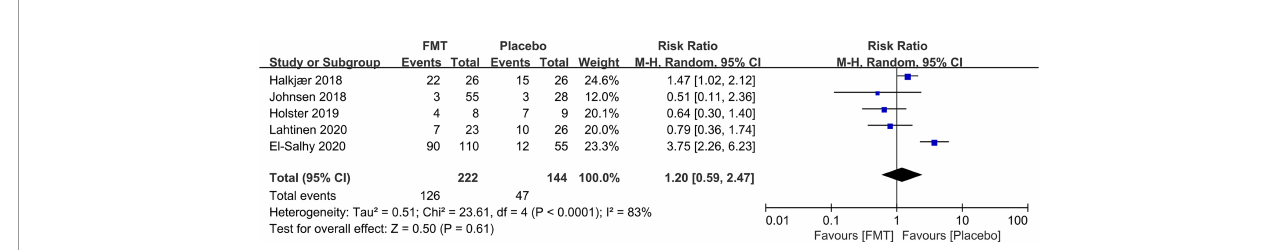
FIGURE 4 | Forest plot of RCTs of adverse events in comparison between FMT and placebo in irritable bowel syndrome.